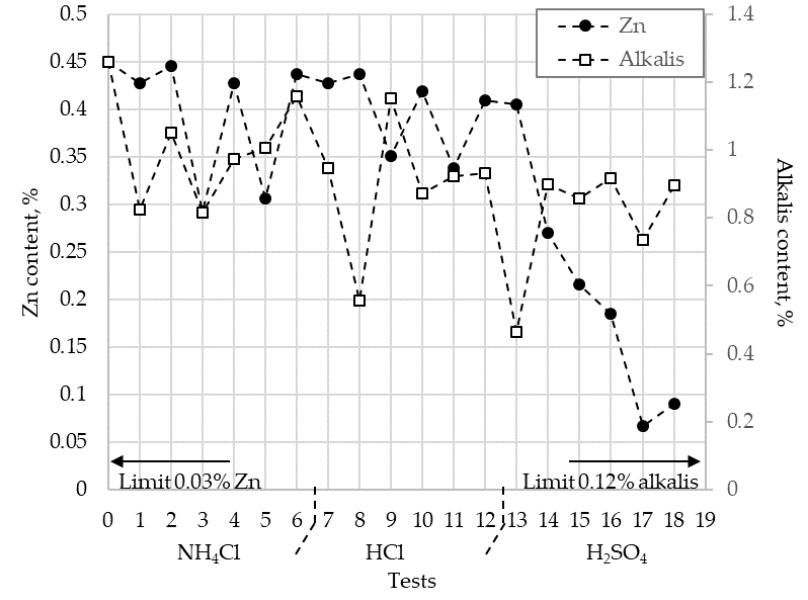
Figure 5. Zn and alkalis content in the BFS at different experimental conditions.